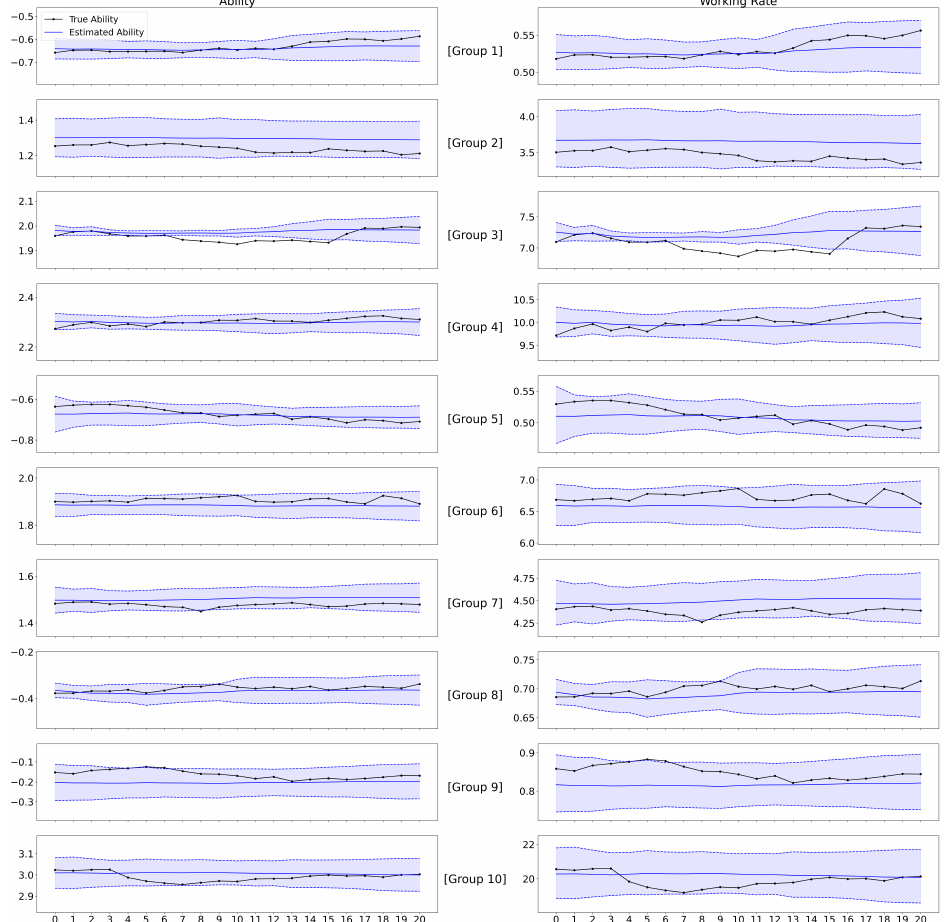
Figure 3. The ability (left) and working rate (right) estimates for all of the groups i ∈ [ G ] of the first dataset in the case of N w = 50. The x -axis represents time. The true ability x i ,0: T and working rate µ i ,0: T for each group i ∈ [ G ] are represented as black solid lines with markers. The estimated ability ˆ x i ,0: T and working rate ˆ µ i ,0: T values are represented as blue solid lines. The dashed line represents the ± 2 standard deviation of L = 200 particle sequences for each group.